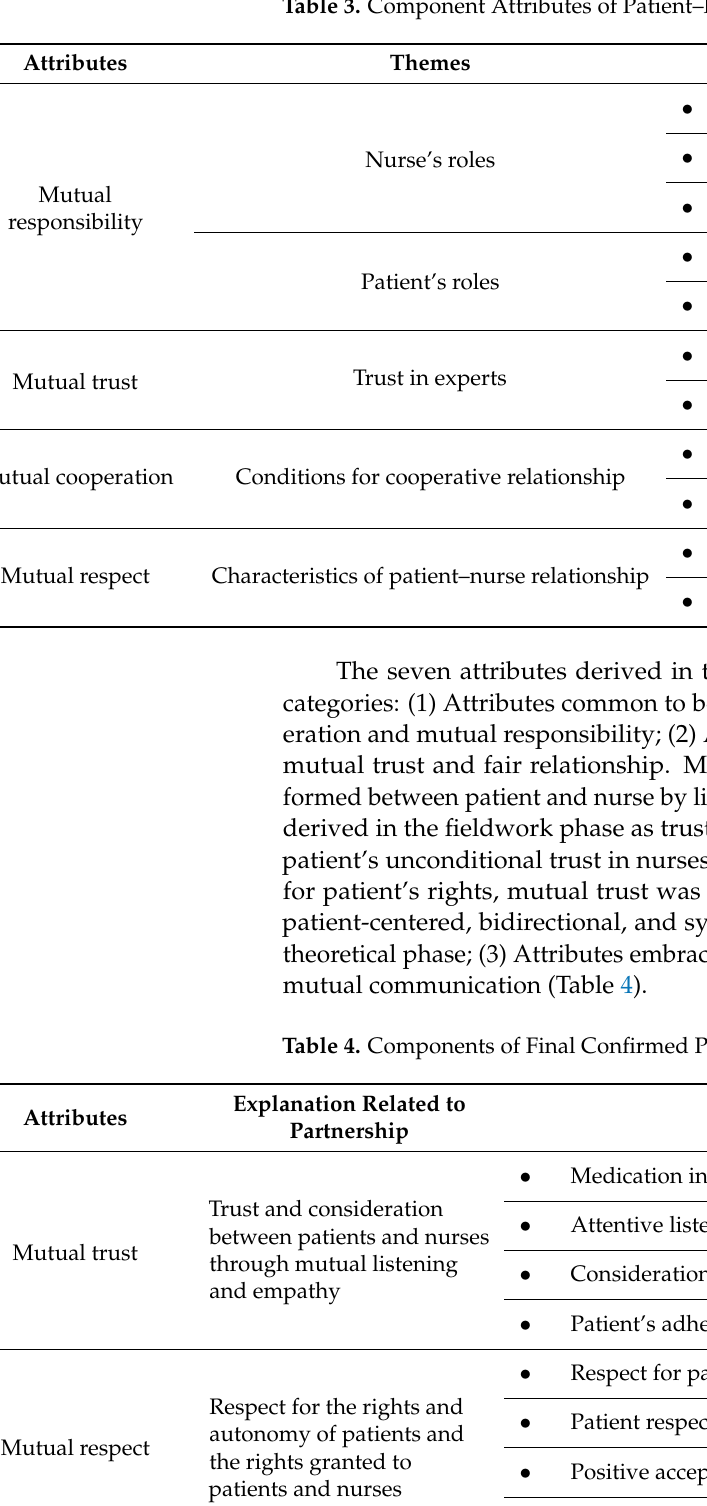
Table 3. Component Attributes of Patient–Nurse Partnership in Field Work Stage.